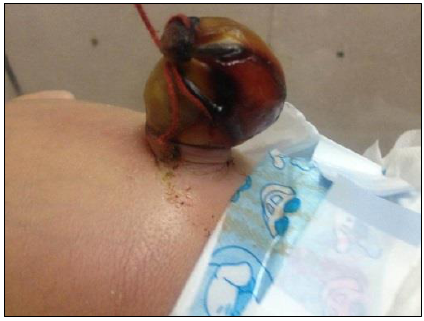
Figure 8: HUC hardly escaped injury by thread ligature by a birth attendant in village